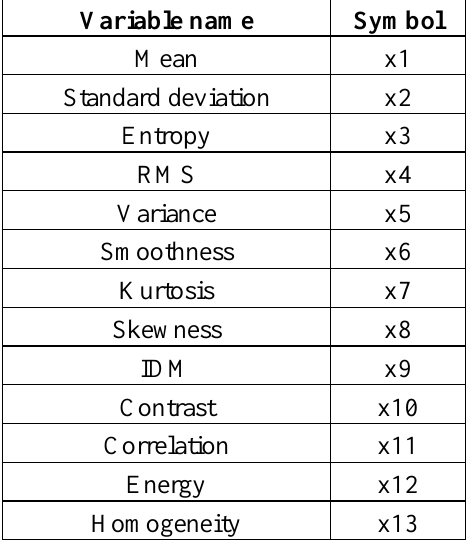
Table 2: Variables adopted in this study as described in the paper mentioned previously in this